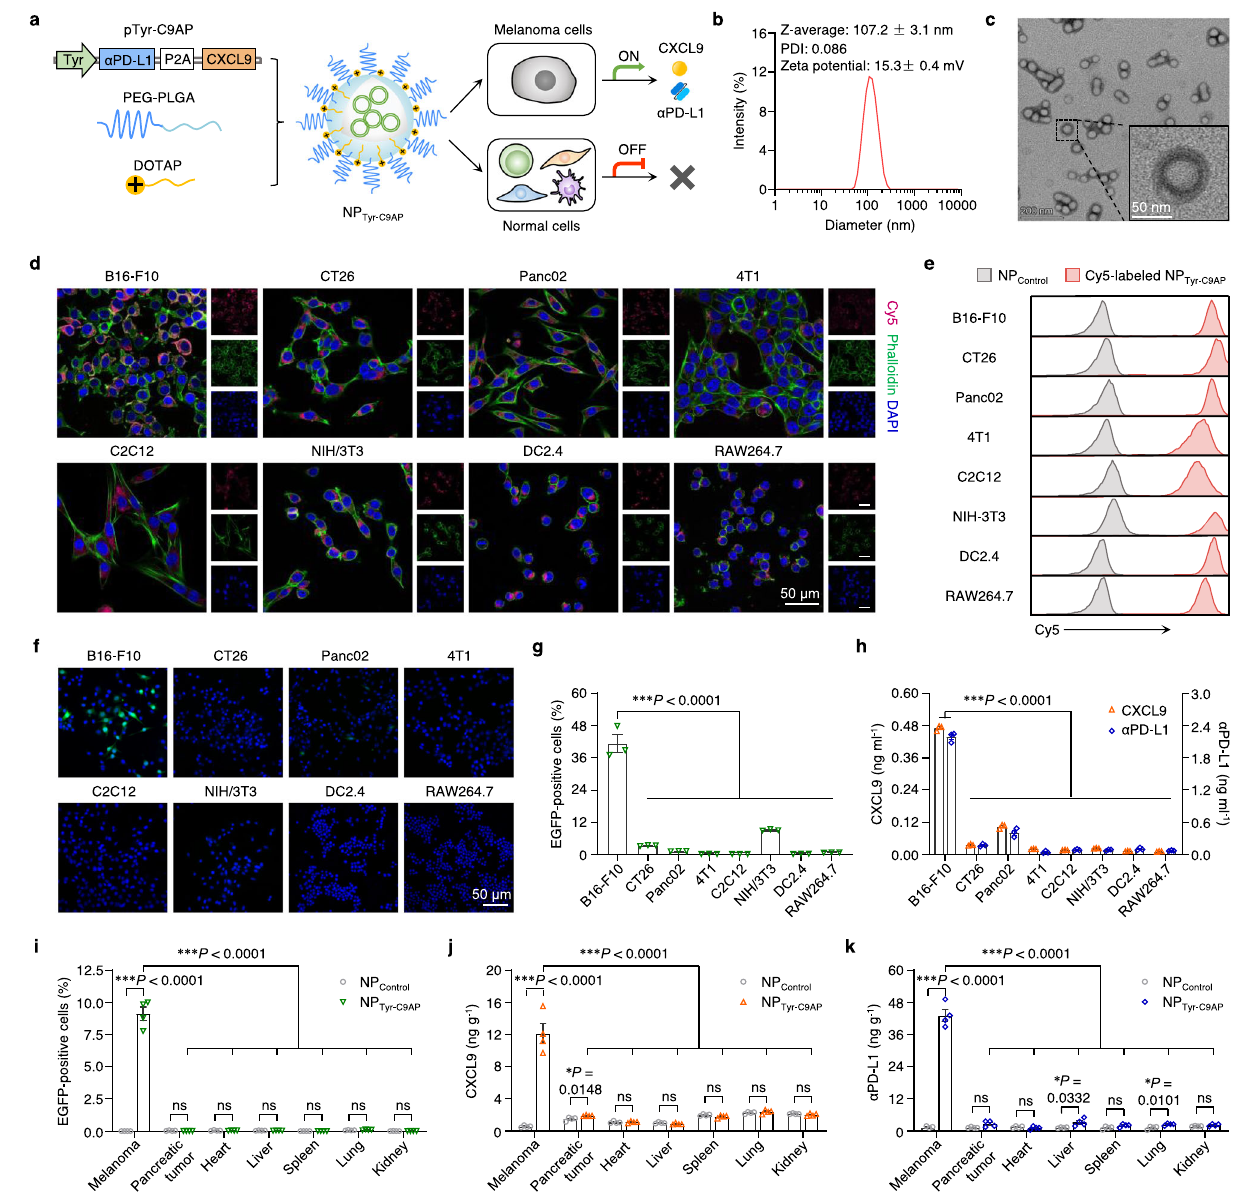
Fig. 2 | Engineering NP Tyr-C9AP for melanoma-speci fi c coexpression of CXCL9 and α PD-L1. a Scheme of NP Tyr-C9AP construction using PEG-PLGA and DOTAP to encapsulate pTyr-C9AP. NP Tyr-C9AP can deliver pTyr-C9AP into melanoma cellsand other normal cells, but the Tyr promoter of pTyr-C9AP will only turn on in mela- noma cells to drive the coexpression of CXCL9 and α PD-L1. b Hydrodynamic dia- meter, PDI and zeta potential of NP Tyr-C9AP . c Morphology of NP Tyr-C9AP . Scale bar, 50nm. d,e CLSMimaging( d )and fl owcytometryanalysis( e )ofCy5 fl uorescencein B16-F10, CT26, Panc02, 4T1, C2C12, NIH/3T3, DC2.4 and RAW264.7 cells after the transfection of Cy5-labeled NP Tyr-C9AP (magenta). F-actin and nuclei were labeled with Alexa Fluor 488 phalloidin (green) and 4 ’ ,6-diamidino-2-phenylindole (DAPI, blue). Scale bar, 50 μ m. f, g Fluorescence imaging of EGFP expression ( f ) and per- centages of EGFP-positive cells ( g ) in B16-F10 cells and the other 7 types of cells